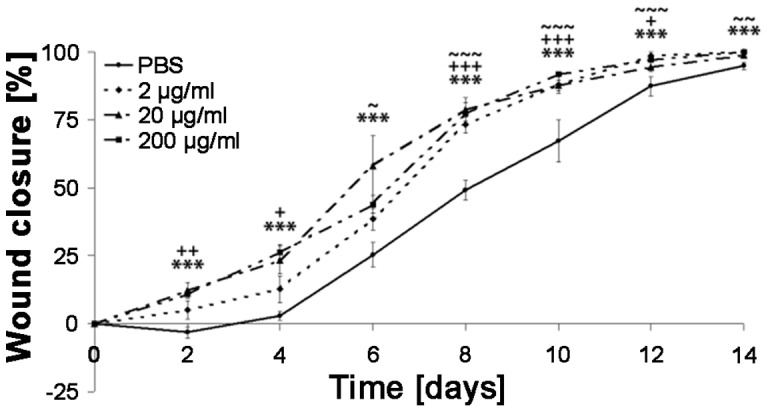
Efficacy in wound healing of IDR-1018 peptide in a murine dose-response model.Peptides were administered every 48 hours with the indicated concentrations of IDR-1018 or PBS (negative control). Re-epithelialization/wound closure was measured every second day. Standard deviation was assessed as SEM (Superscript symbols *, +, and ∼ represent 15 µl doses of 3, 0.3 and 0.03 µg respectively; *,+,∼  = p<0.05; **,++,∼∼  = p<0.01; ***,+++,∼∼∼  = p<0.005 compared to vehicle control).